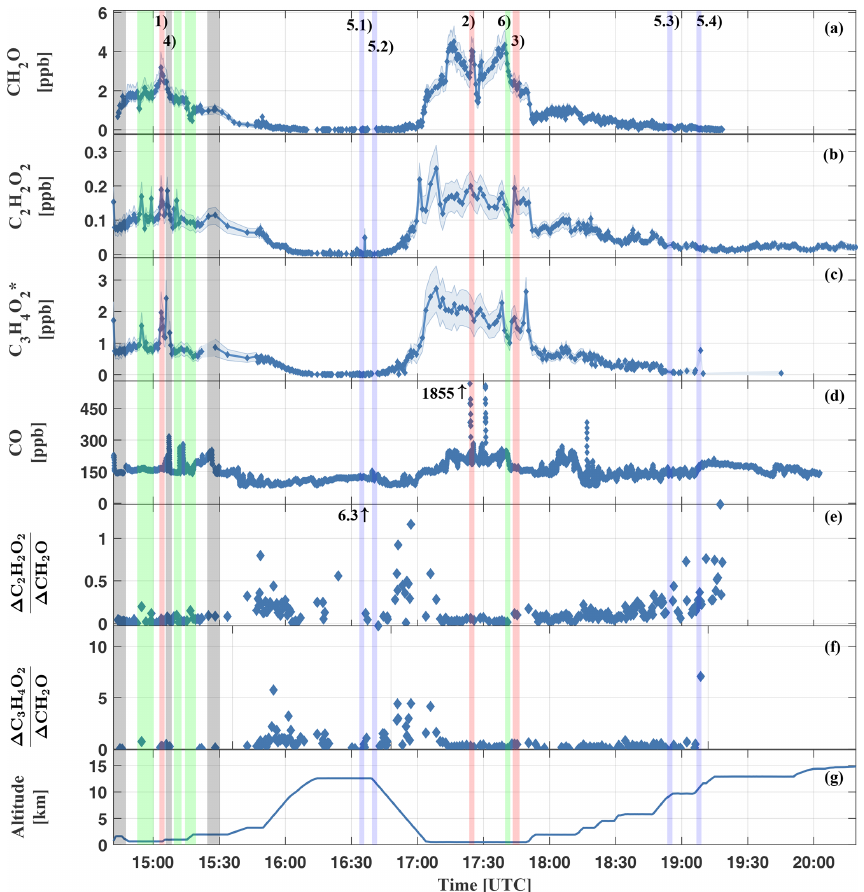
Figure 8. Measured mixing ratios of CH 2 O (a) , C 2 H 2 O 2 (b) , C 3 H 4 O ∗ (c) , CO (d) , inferred R GF = (cid:49) C 2 H 2 O 2 /(cid:49) CH 2 O (e) , R MF = 2 (cid:49) C 3 H 4 O ∗ /(cid:49) CH 2 O (f) , and the height versus time trajectory for the HALO flight AC11 (g) . The shaded blue area in (a–c) shows the 2 respective measurement uncertainty. All measurements within the Manaus city plume are marked by grey bars (e.g. event AC11-4). Exam- ples for measurements in aged air masses of the upper troposphere are marked in blue (e.g. events AC11-5.1–5.4) and green for the general background atmosphere; i.e. tropical-forest-affected air (e.g. event AC11-6). All measurements of biomass burning plumes are labelled in red (events AC11-1, AC11-2, and AC11-3). The event numbers correspond to the labelling in Table 3 and Fig.